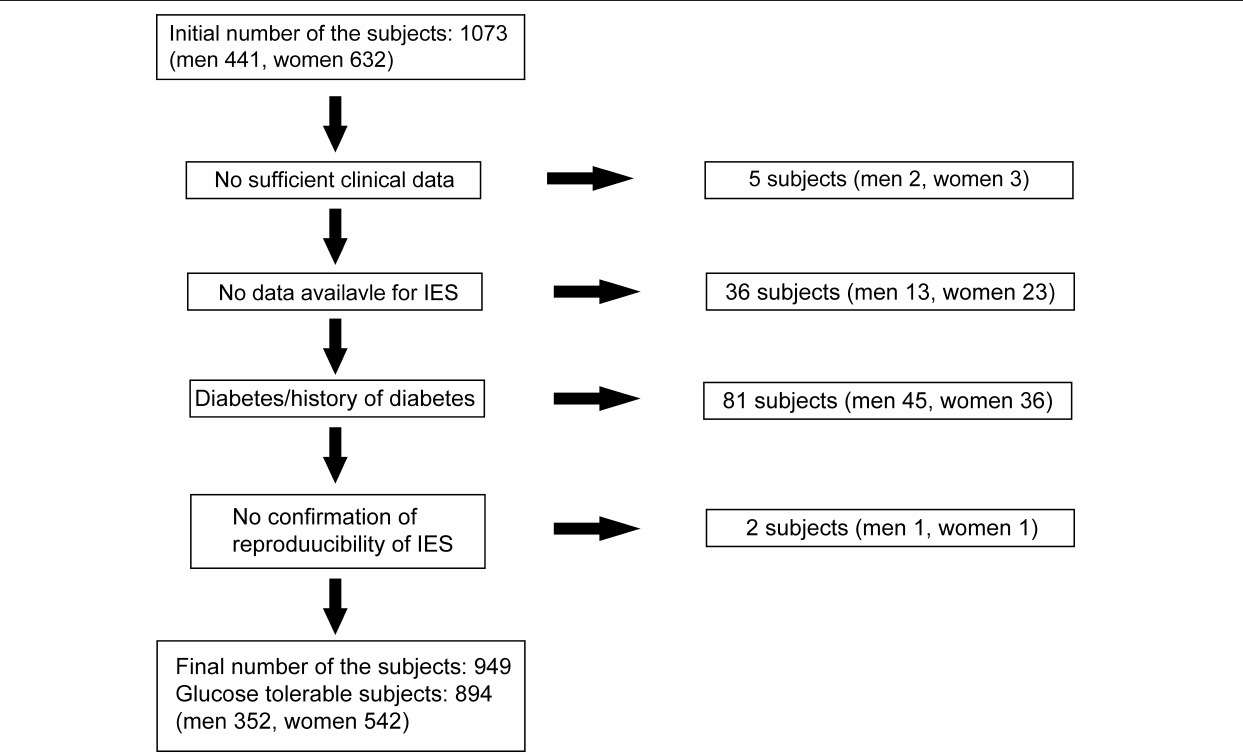
FIGURE 1 | Subjects selection. Eight hundred ninety-four normoglycemic precipitants (352 men, 542 women) were finally examined out of 1,073 volunteers from the Iwaki study 2017 in this study.